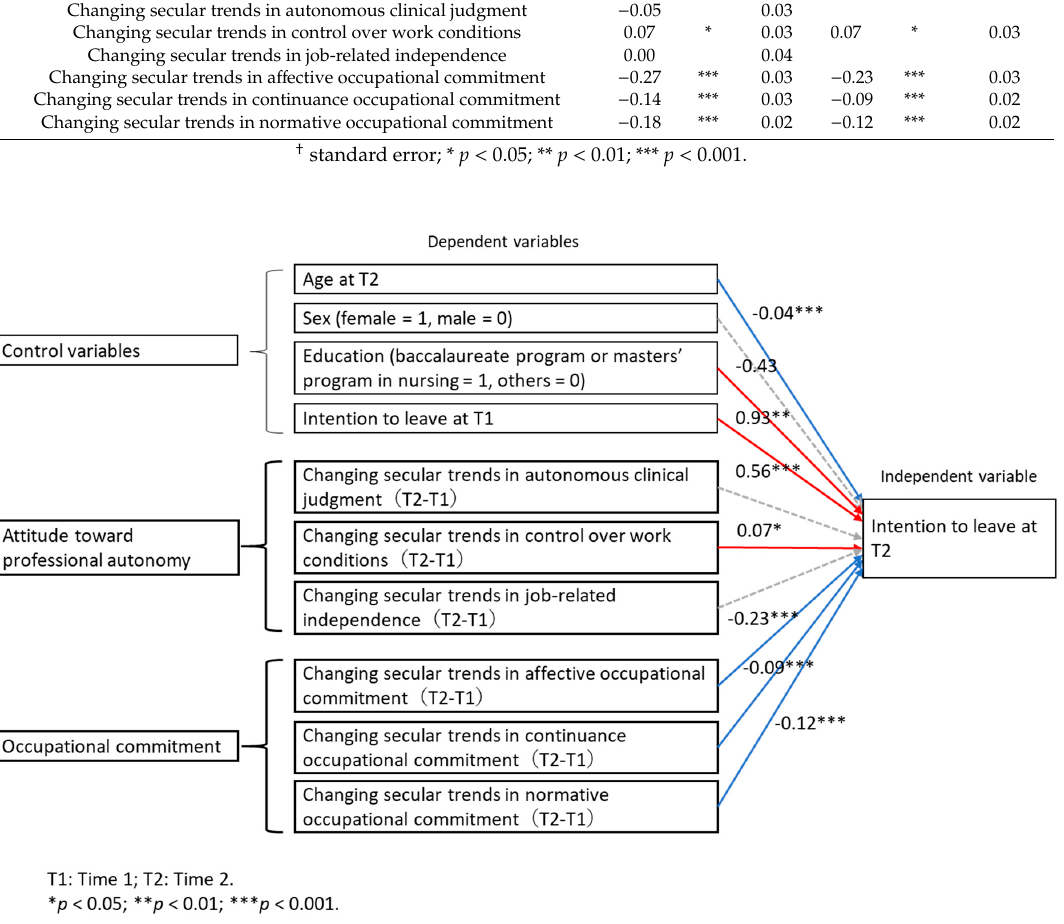
Figure 2. Generalized estimating equation results. The solid blue arrows represent that increasing age and increasing changing secular trends in affective OC, continuance OC, and normative OC decrease intention to leave at Time 2. The solid red arrows represent that higher education, increasing intention to leave at Time 1, increasing changing secular trends in control over work conditions increase intention to leave at Time 2. The gray dotted arrow indicates that there was no significant effect.